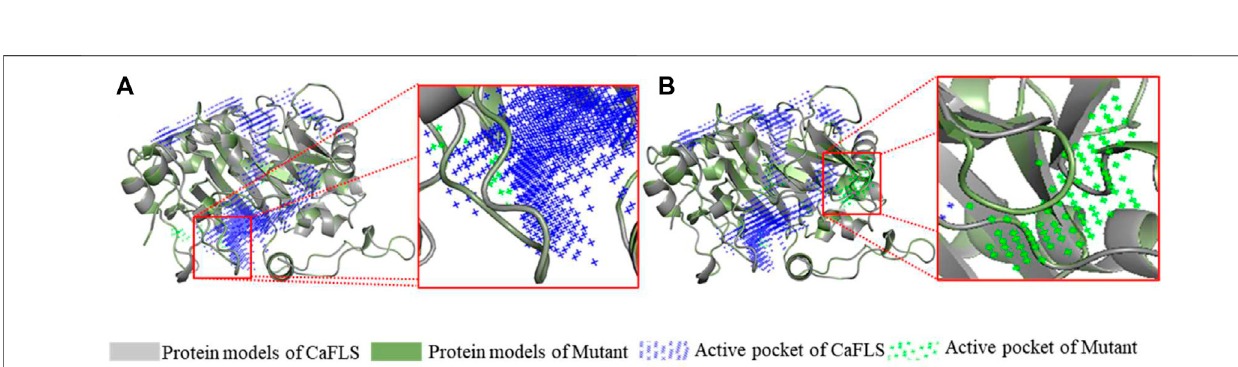
FIGURE7| Activepocketdifferencesofmutantand wild-typeCaFLS.Note: (A) Activepocket differences ofmutant 01and wild-typeCaFLS(Alterations indepth). (B) Active pocket differences of mutant 02 and wild-type CaFLS (Increases the active pocket).